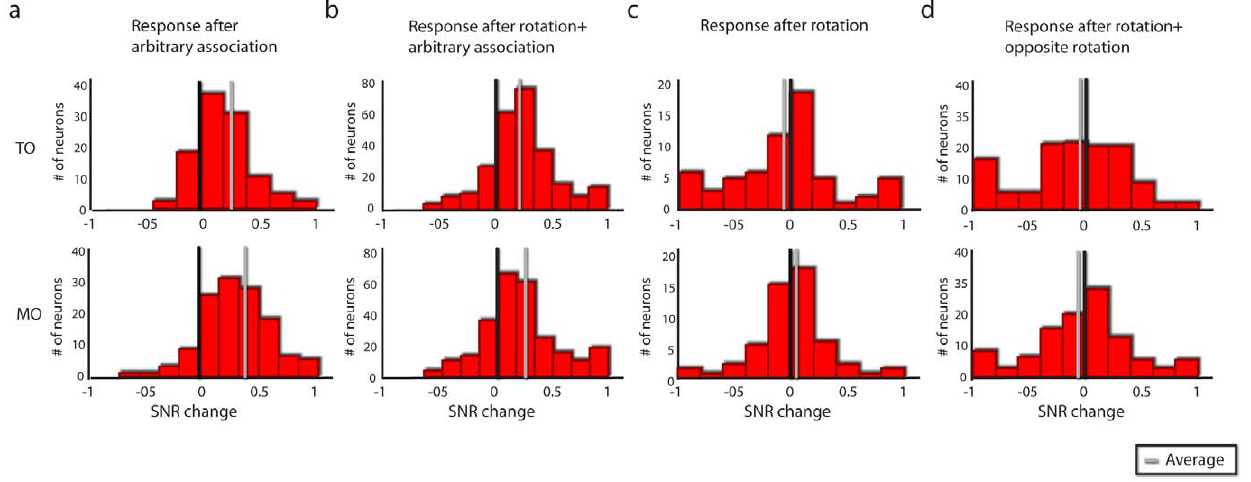
Figure 3. Additional analysis of color sensitivity. Change in the SNR for different target colors during the TO epoch (upper panel) and MO (lower panel), where positive values indicate an increase in SNR after learning: (a) an arbitrary association task alone; (b) arbitrary association following rotation; (c) rotation alone or (d) rotation followed by the opposite rotation. Grey lines indicate the mean of the post-learning distribution, black lines represent zero change. Note that learning an arbitrary association, but not a rotation, resulted in increased SNR.